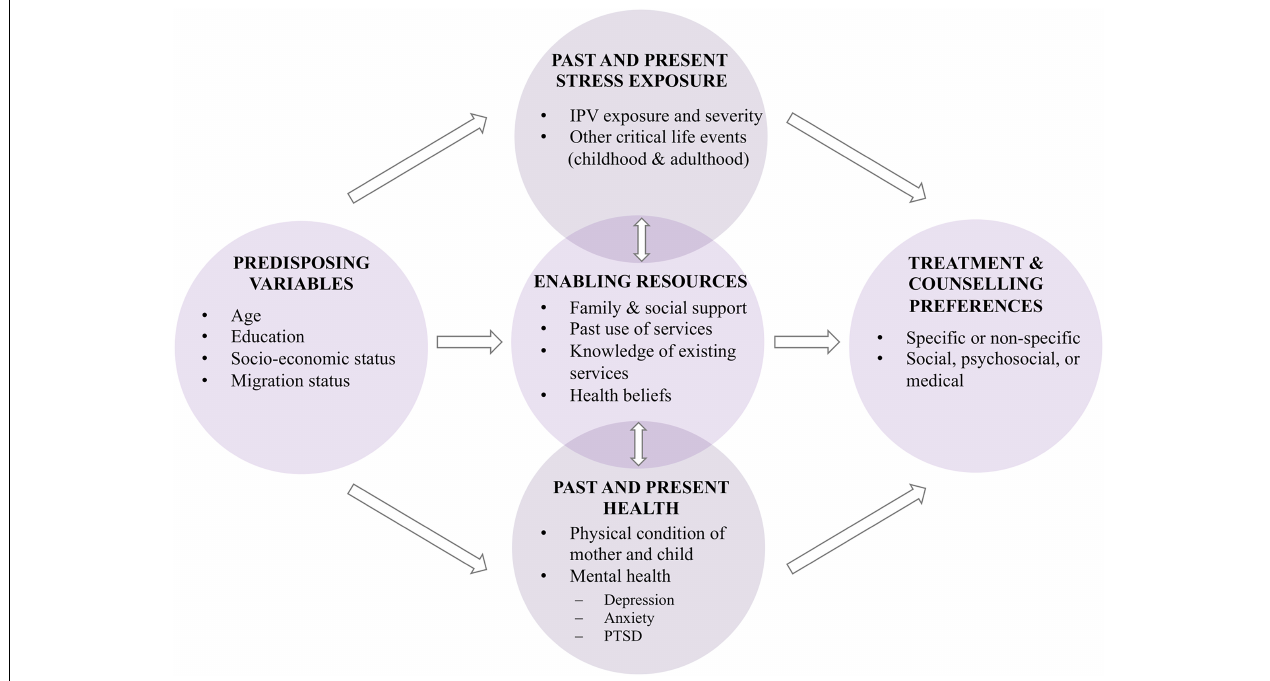
FIGURE 1 | Theoretical framework of the INVITE study. Adapted from Andersen (91) and Liang et al.